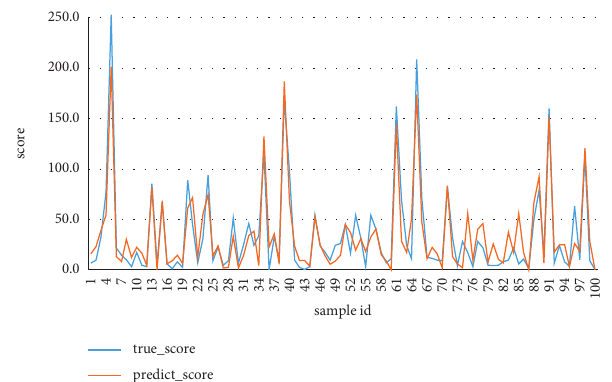
Figure 6: Comparison of prediction errors in Sharp scoring for RA disease. The graph shows the distribution of the score in the test dataset used to compare the true score and predicted score computed by the ResNet-Dwise50 model with transfer